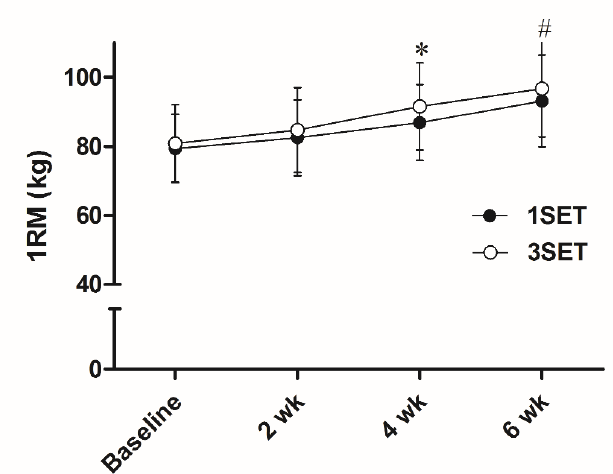
Figure 2. Maximal isoinertial strength (1RM) along the 6-wk resis- tance training program.